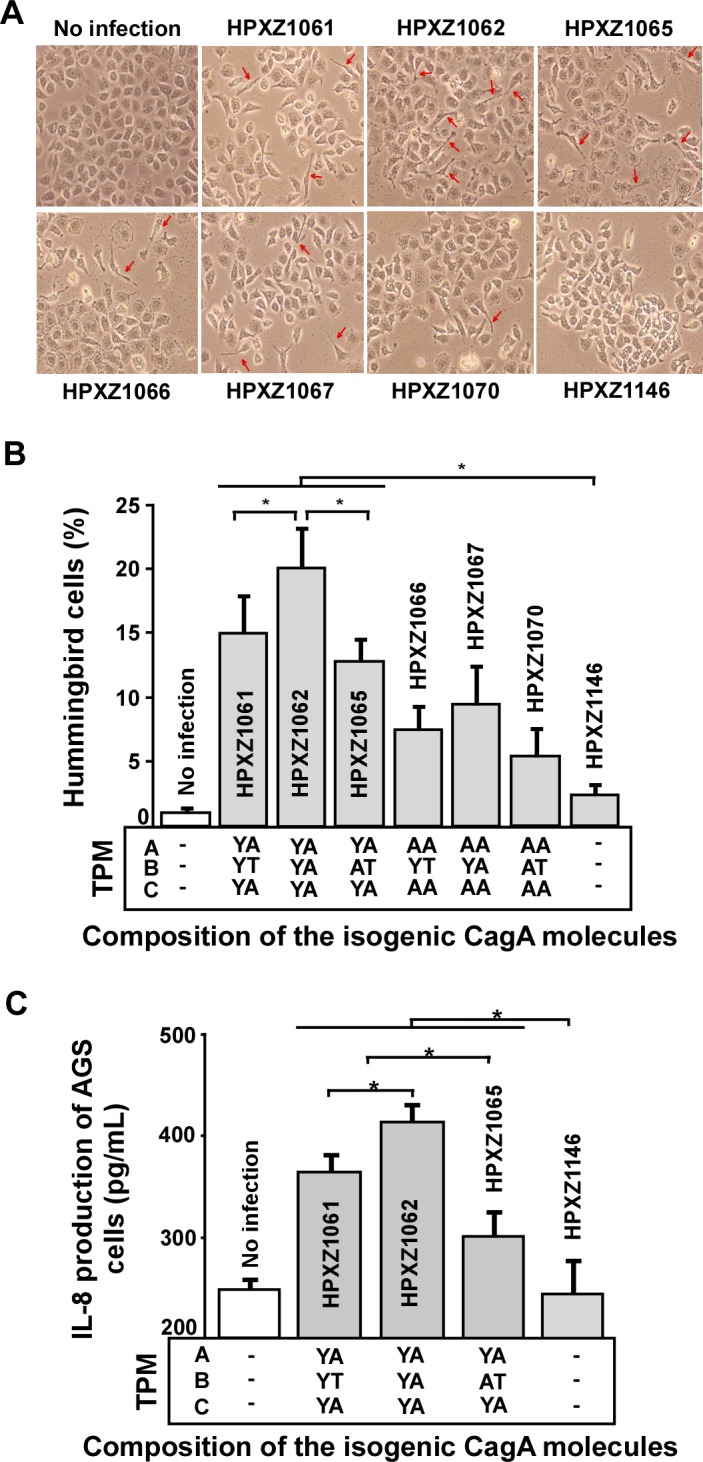
Analysis of the hummingbird phenotype and IL-8 induction after co-culture of human AGS cells with isogenic H. pylori strains containing the engineered CagA molecules.
Panel A: AGS cells were co-cultured with the isogenic H. pylori strains at a multiplicity of infection (MOI) of 100:1 for 24 h; cell morphology was observed using microscopy. Red arrows indicate needle-like hummingbird cells. Panel B: The mean (+SD) proportion of hummingbird cells induced by the H. pylori isogenic cagA mutants during co-culture. *: p<0.05, Student’s T-test. Panel C: AGS cells were co-cultured with the isogenic H. pylori strains at a multiplicity of infection (MOI) of 100:1. The media were sampled at 24 h, centrifuged at 16,000 g, and supernatants collected. AGS cell IL-8 secretion (Mean+SD) was measured by an enzyme-linked immunosorbent assay. *: p<0.05, Student’s T-test.